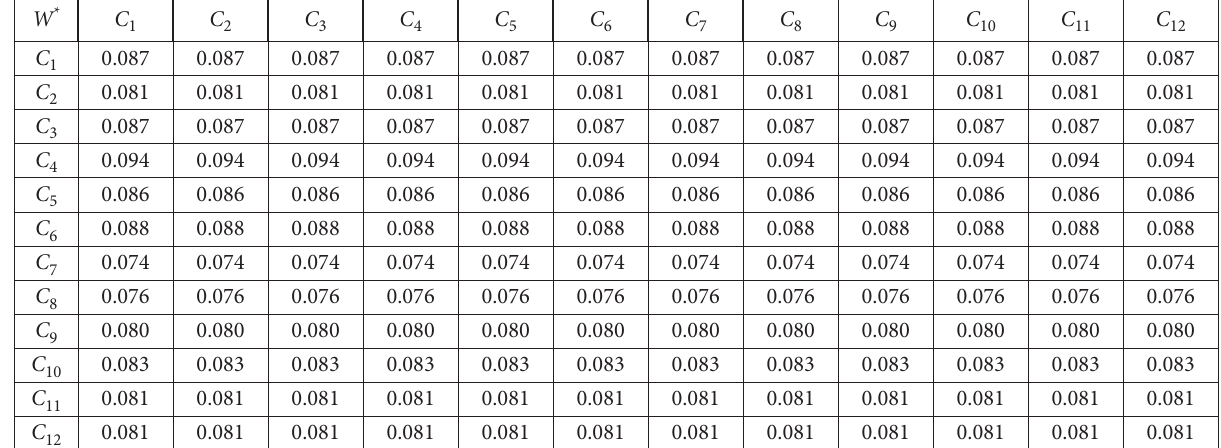
Table 4. The stable matrix of